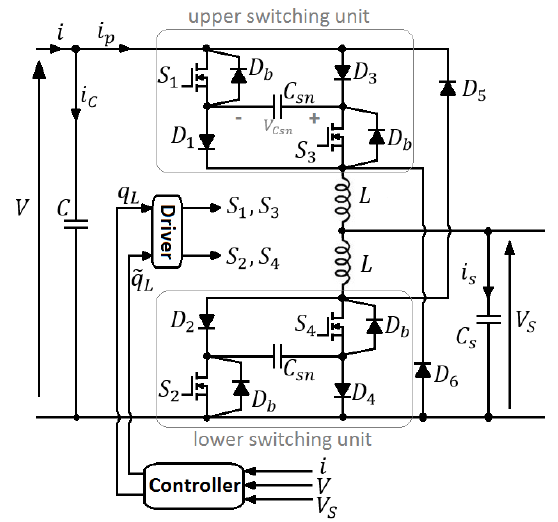
Figure 2. The proposed new VIC circuit, D b , denotes a body diode of a MOSFET switch.